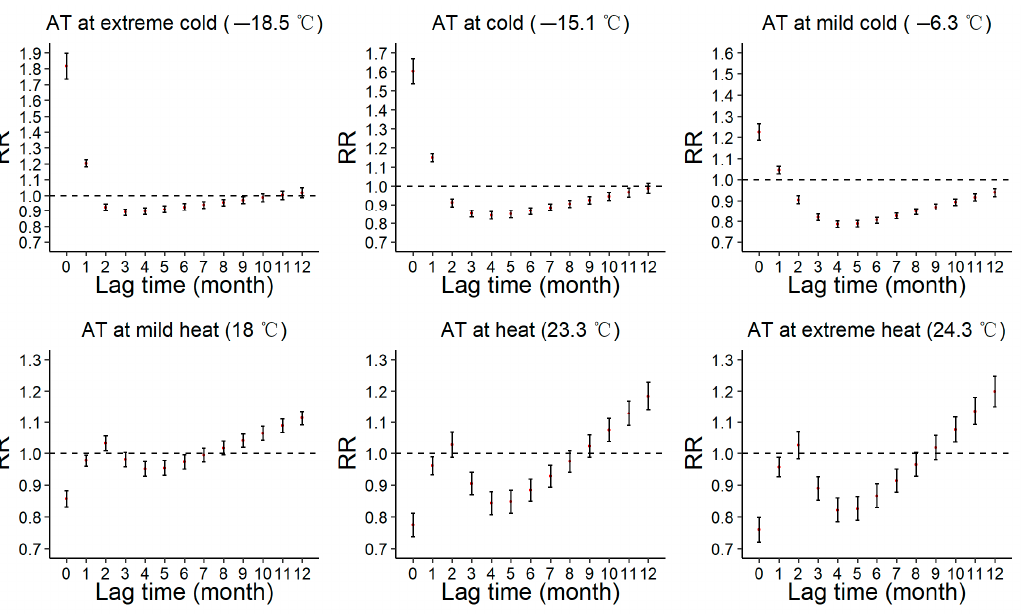
Figure 4. The exposure-lag-response correlations between meteorological factors and the incidence of PTB in Xinjiang from 2004 to 2019. ( A ) represents the 3–D graph of the relationship between AT and PTB incidence, ( B ) represents the overall cumulative relative risk of AT on PTB incidence across lag 0–12 months, ( C ) represents the heatmap of AT on PTB incidence.